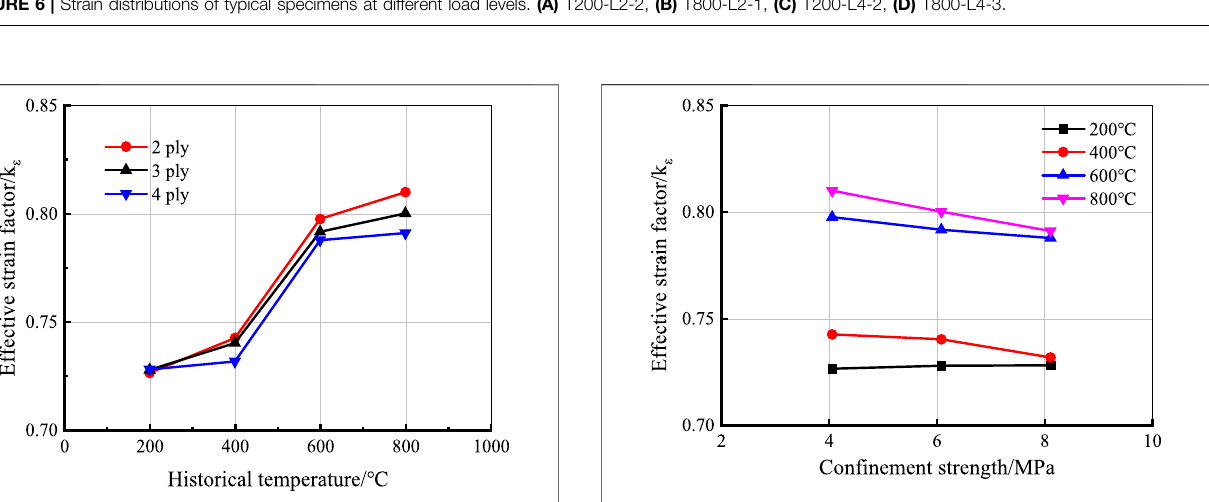
FIGURE 6 | Strain distributions of typical specimens at different load levels. (A) T200-L2-2, (B) T800-L2-1, (C) T200-L4-2, (D) T800-L4-3.